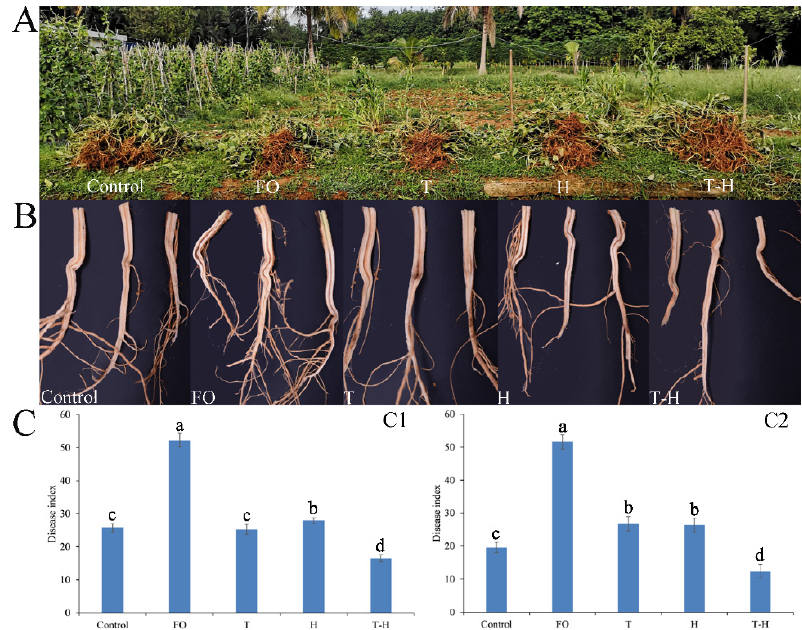
Figure 7. The effect of the combination of T. asperellum SC012 and hymexazol to control cowpea Fusarium wilt in fields. ( A ) The growth status of cowpea; ( B ) the symptoms of cowpea root; ( C ) the disease index of cowpea Fusarium wilt. ( C1 ) and ( C2 ) represent two field experiments conducted in June of 2020 and June of 2021, respectively. “Control”, “FO”, “T”, “H” and “T-H” stand for “blank control”, “negative control”, “ Trichoderma treatment”, “hymexazol treatment” and “combination treatment”, respectively. Data presented are the means ± SE. Different letters indicate significant difference ( p < 0.05) among the treatments.